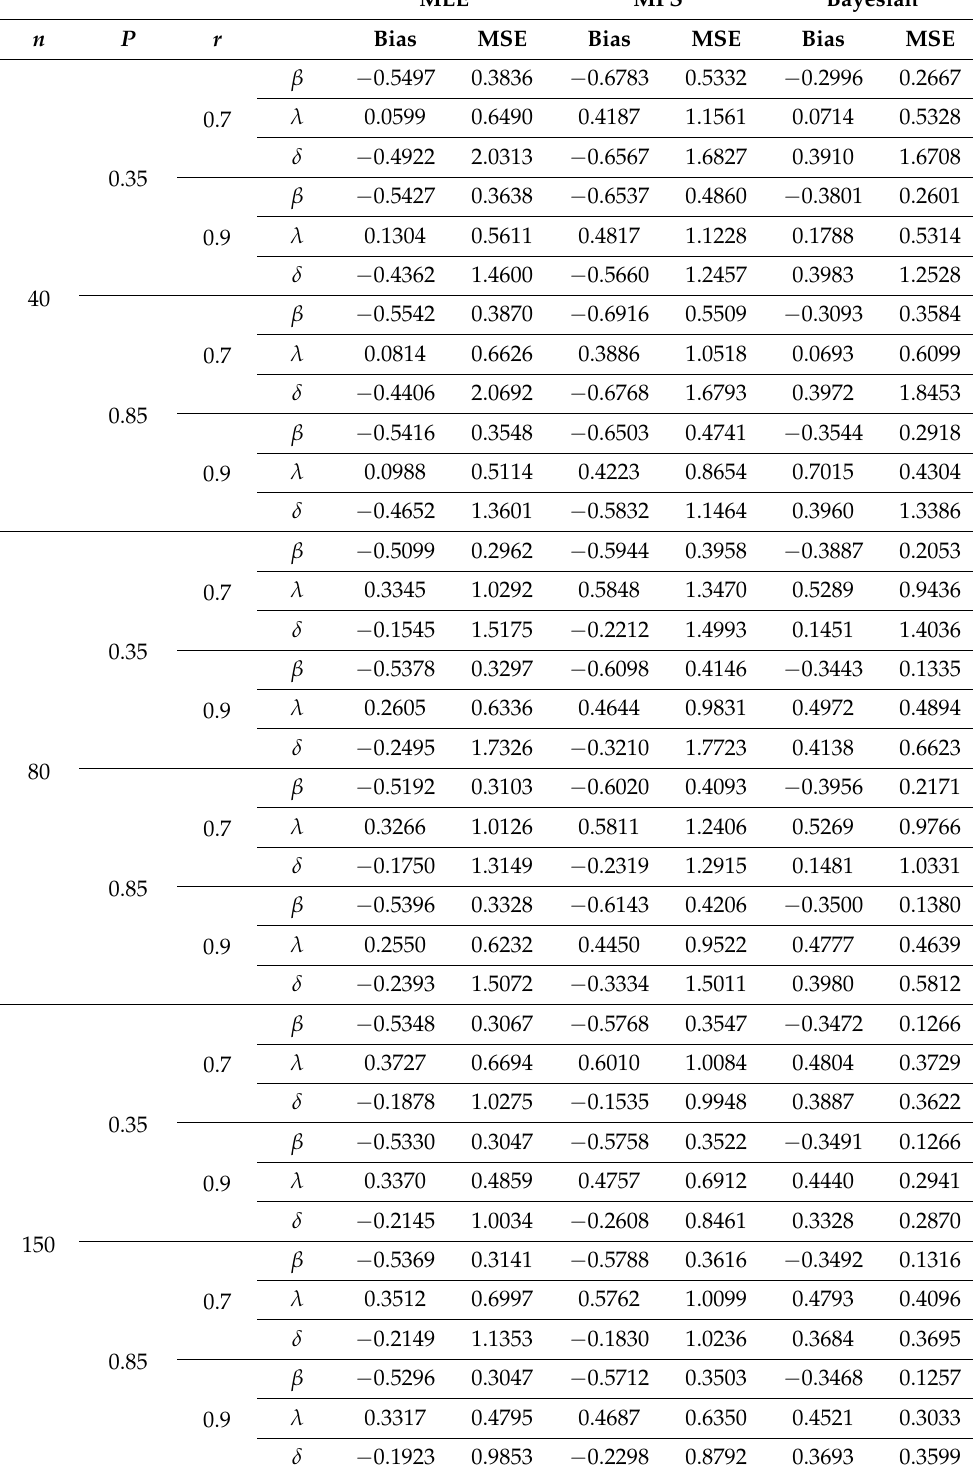
Table 3. The MLE, MPS, and Bayesian of the WE parameters under the PTIICS with random removal for Case